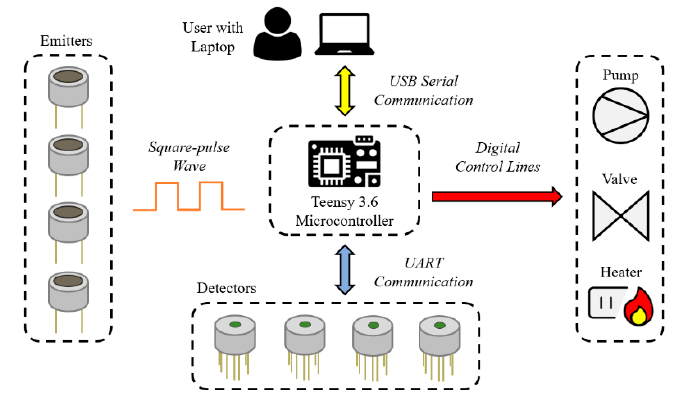
Figure 5. Overview of the optical electronic nose communication/control lines.